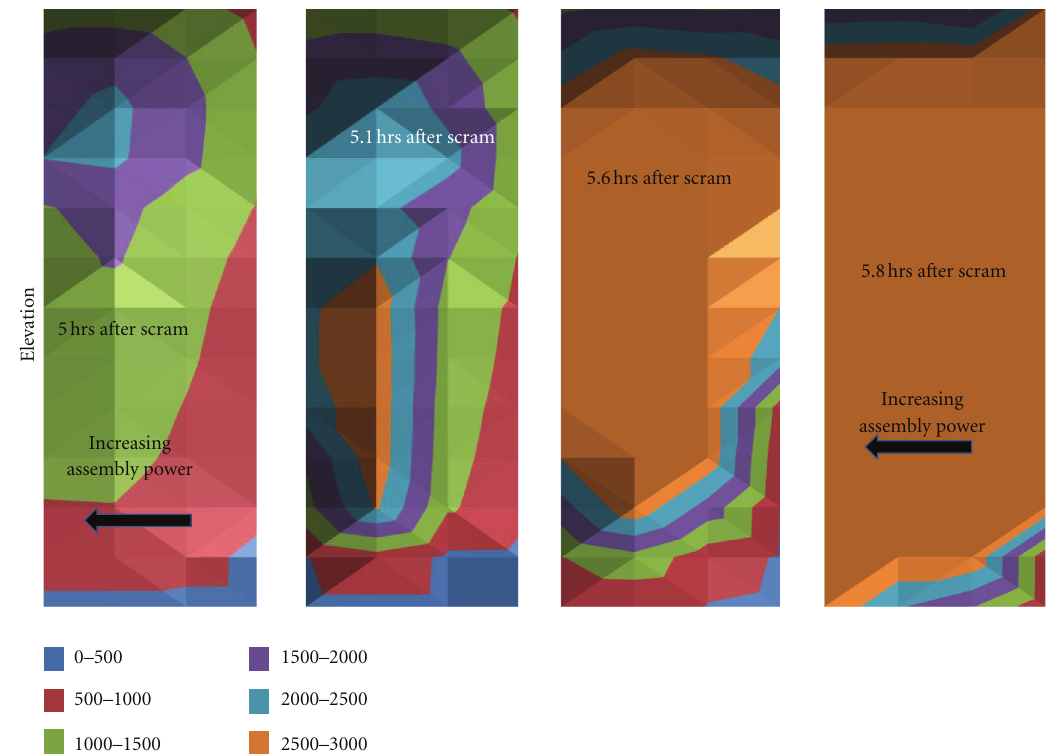
Figure 32: Core temperature distributions for a scenario with depressurization (all emergency water injection excluding the CRDs was terminated at 4.2 hours after reactor